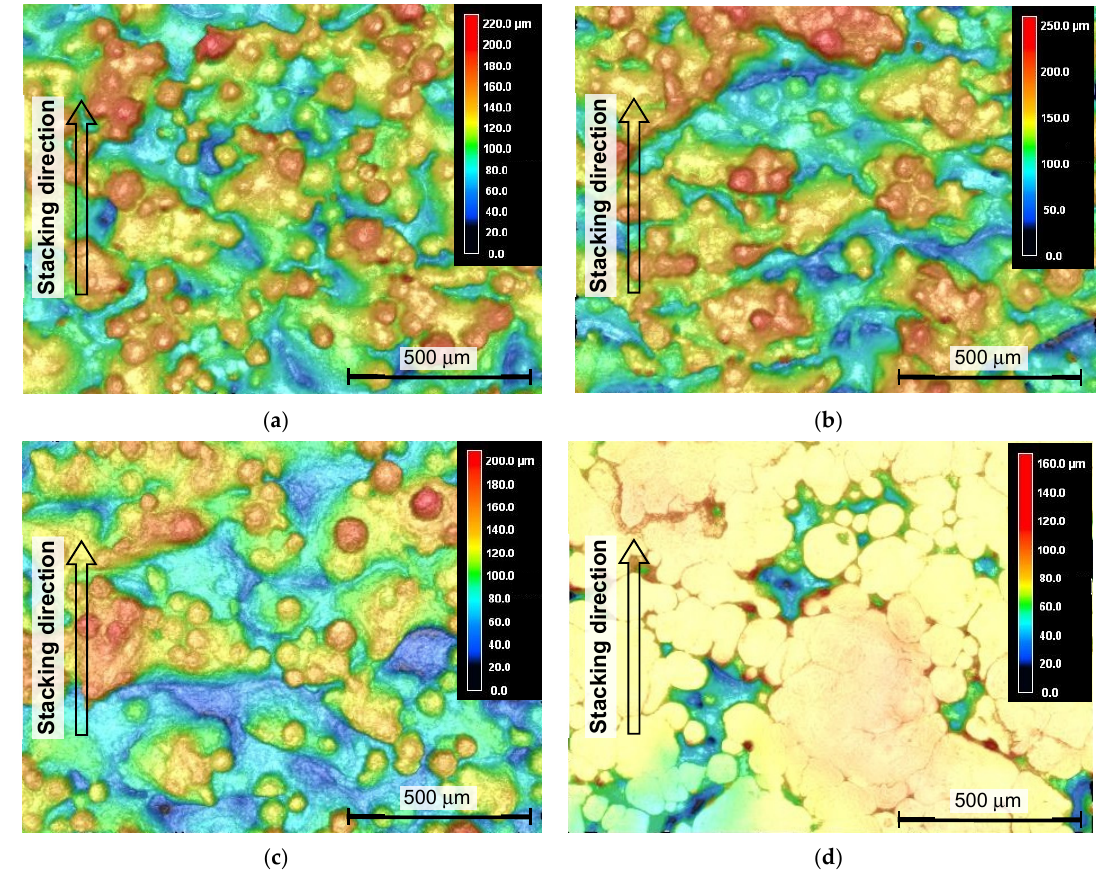
Figure 6. Aspects of the specimen manufactured by EBM, observed by a laser confocal microscope. ( a ) As-built; ( b ) cavitation peening; ( c ) laser peening; ( d ) shot peening.